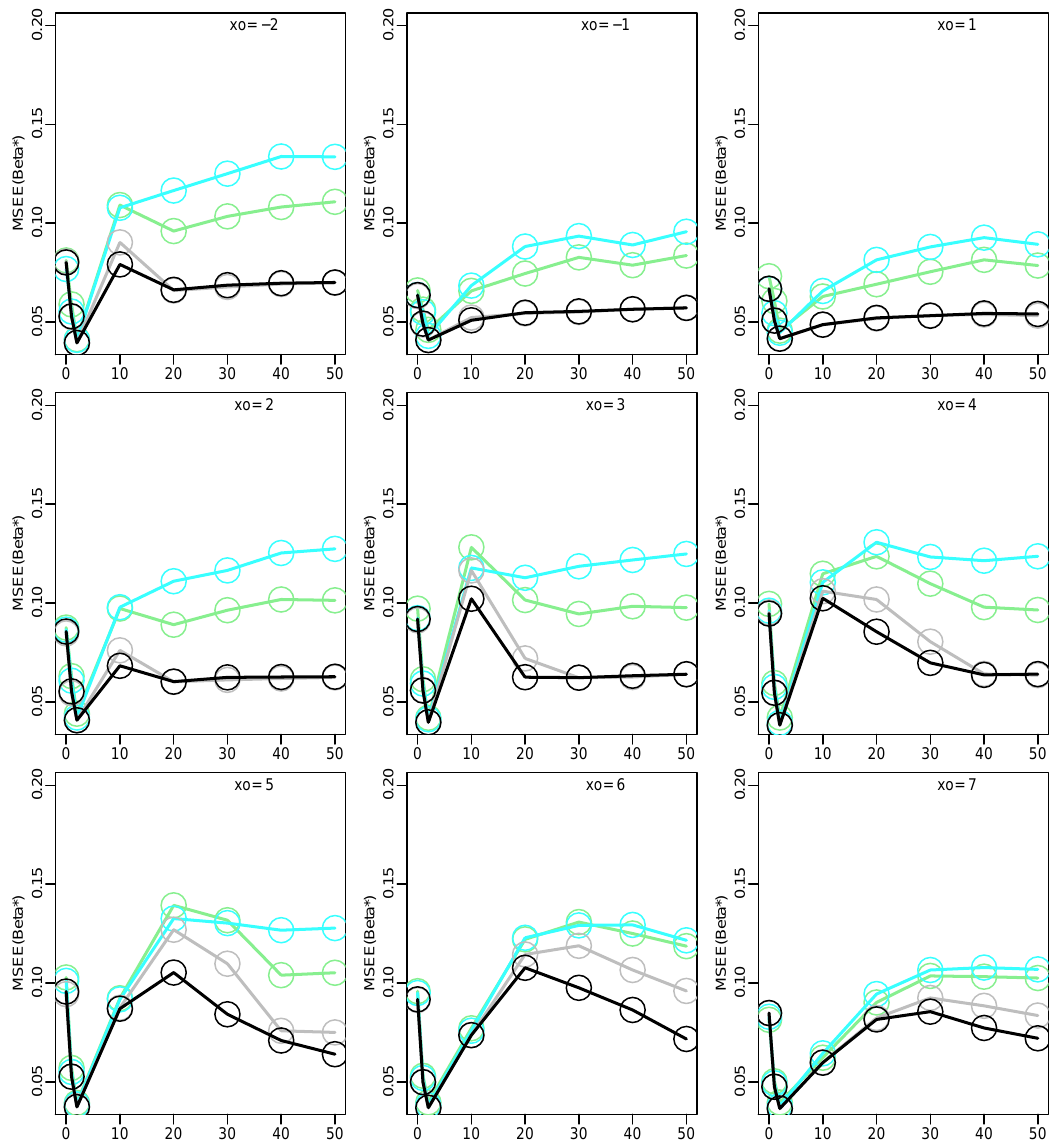
Figure 5. Monte Carlo results for the contaminated multiple regression model. Mean square estimation error MSEE( ˆ β ∗ ) for varying y out and x out . Simple DCML estimates: MD07r + D, light green; MD10r + D, cyan; MCML07 + D, grey; MCML10 + D,